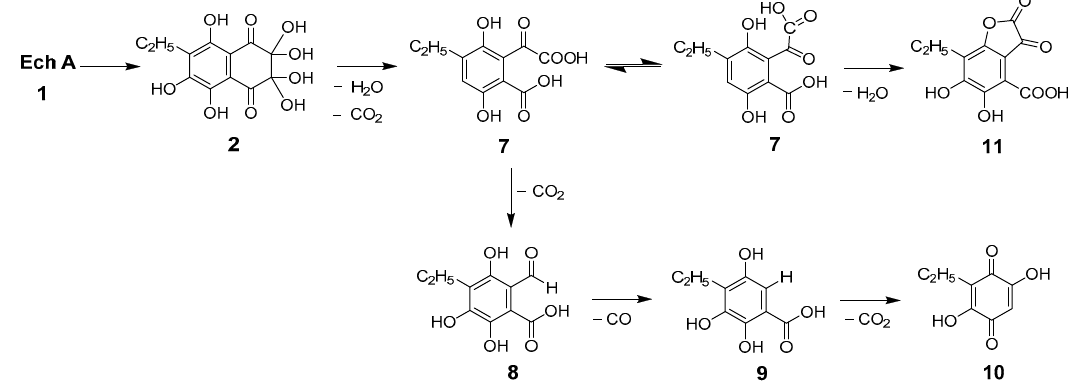
Figure 8. Proposed scheme of the Ech A oxidative degradation process.